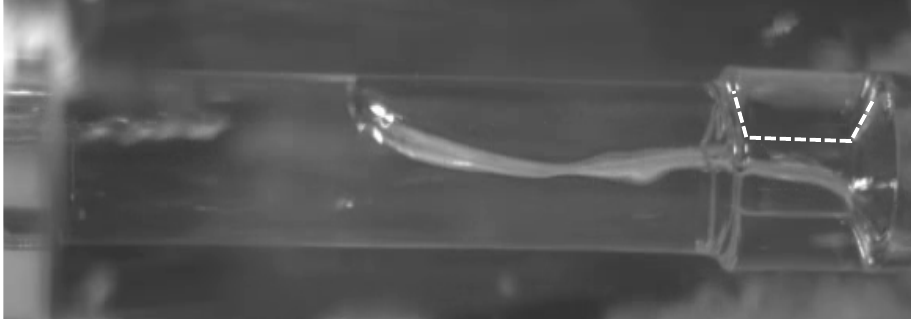
Figure 14. Slug flow upstream of the orifice.